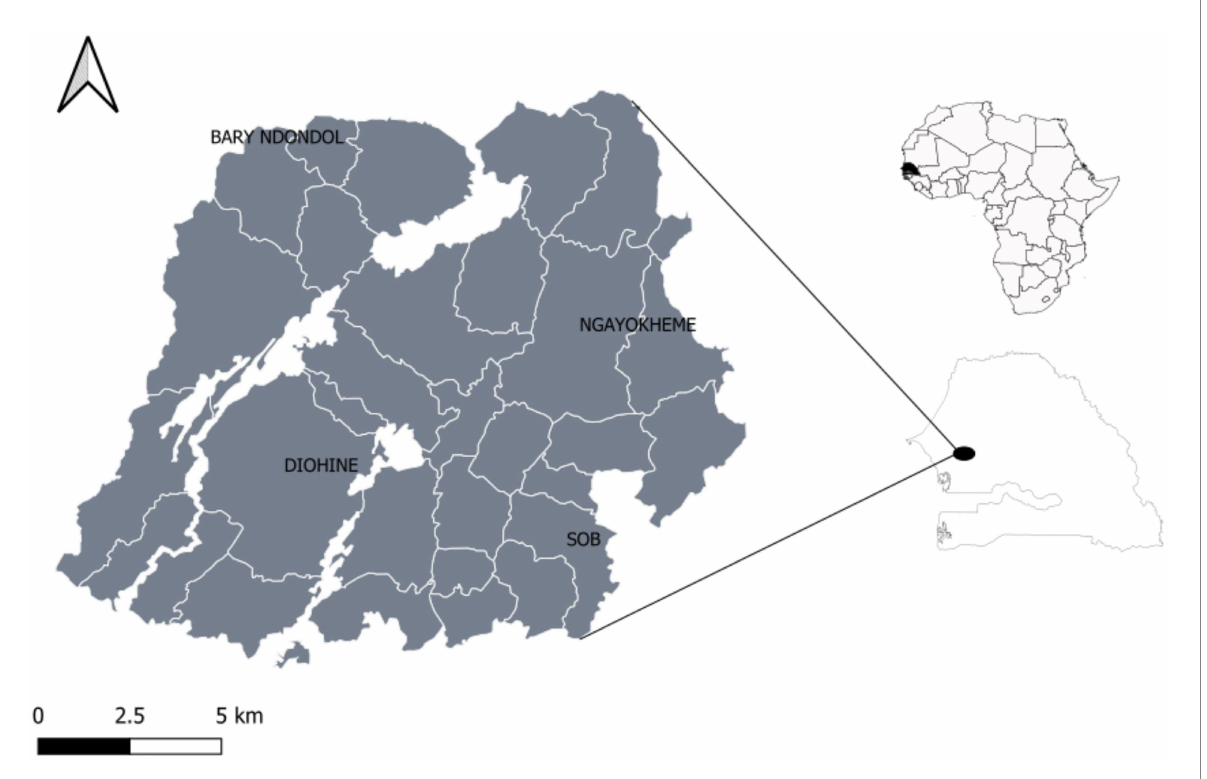
FIGURE 1 Geographic location of study sites within the Niakhar